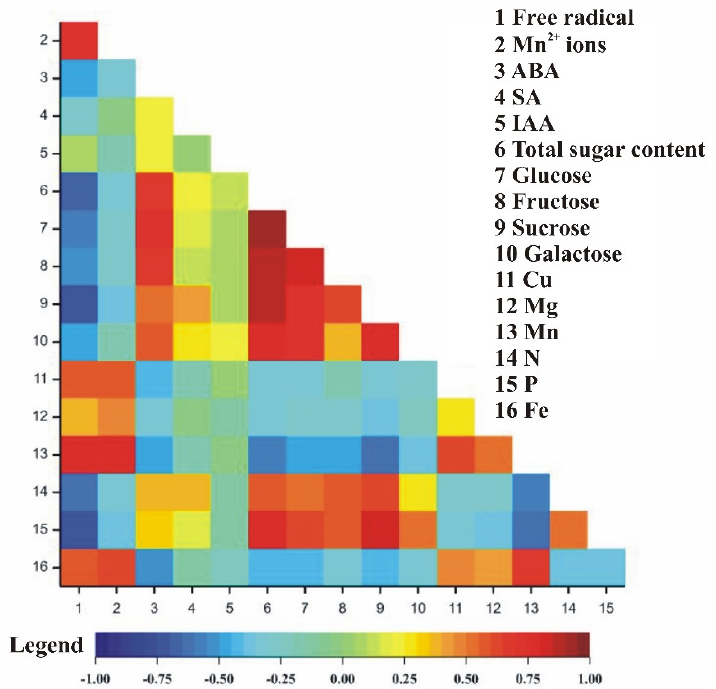
Figure 9. Heatmaps for Pearson’s correlation coefficients between the observed traits ( r 0.001 = 0.23). Each cell denotes correlation coefficient between pair of observed traits. The correlation coefficients ranged from − 1 (blue) to 1 (red).